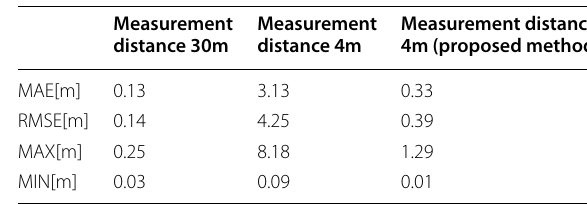
Table 2 Simulation results for dealing with degeneracy in the